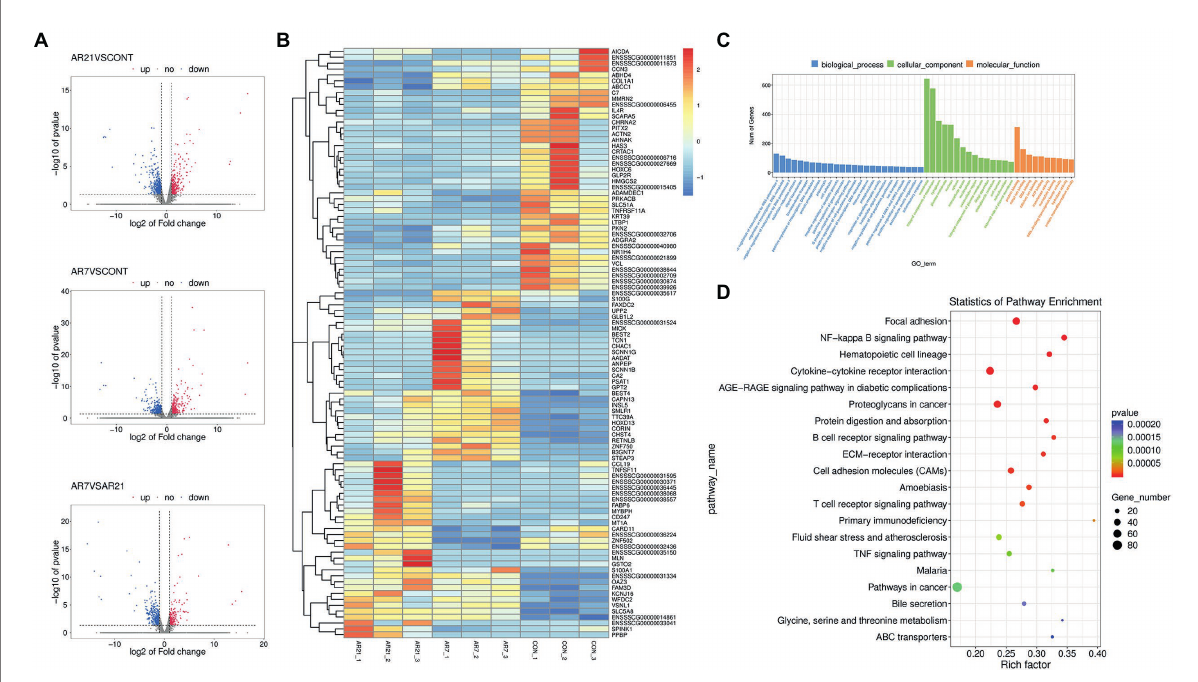
FIGURE 6 Effects of artificial rearing on the transcriptome profile in piglet colon. (A) The volcano plot for the DEGs. Blue dots mean the up-regulated genes. Red dots mean the down-regulated genes. Grey dots mean the genes with no significant changes. (B) Heatmap of DEGs in RNA-seq. Relative expression of DEGs where red hues represent comparatively upregulated genes and blue hues represent comparatively downregulated genes (scale at right). (C) GO enrichment analysis of DEGs. (D) KEGG pathway enrichment analysis of DEGs. n = 3